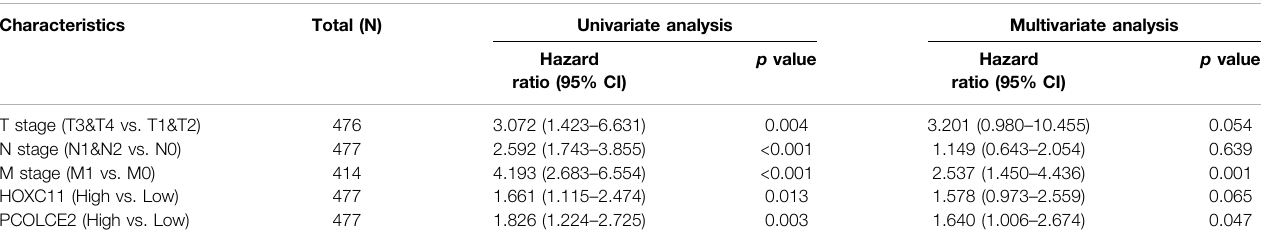
TABLE 3 | Univariate and multivariate analysis of targeted genes combing with clinical factors.